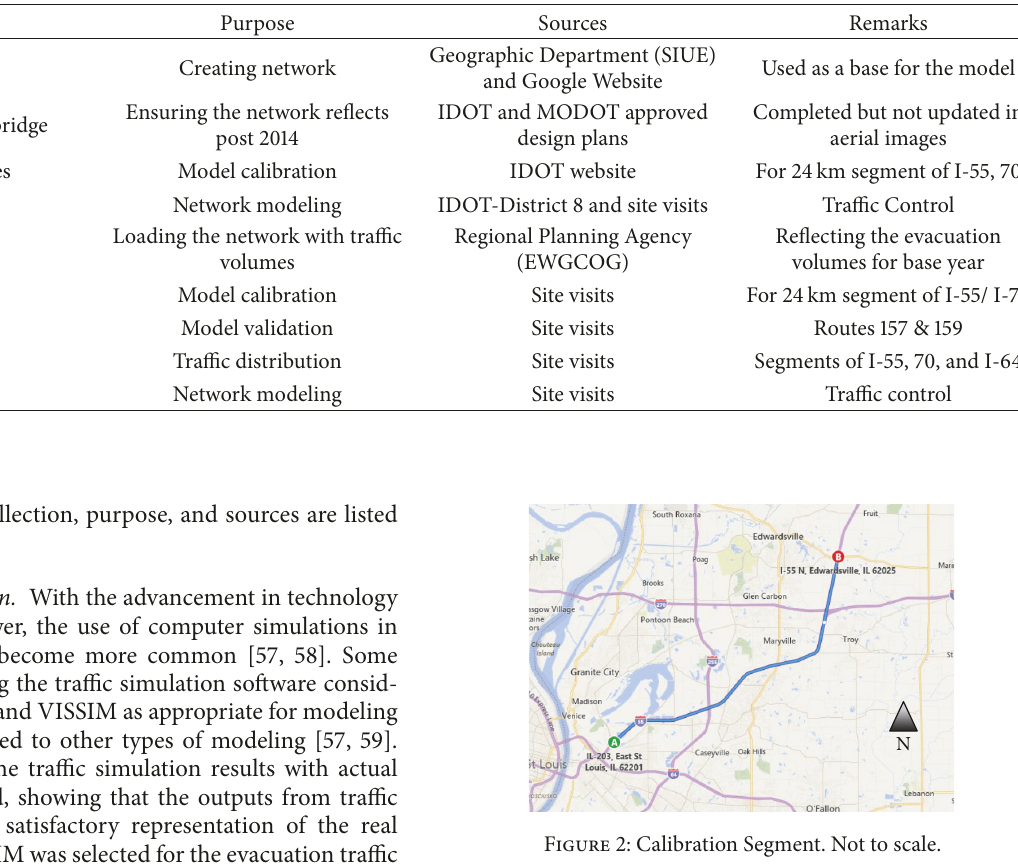
Table 4: Data collection and sources [56].